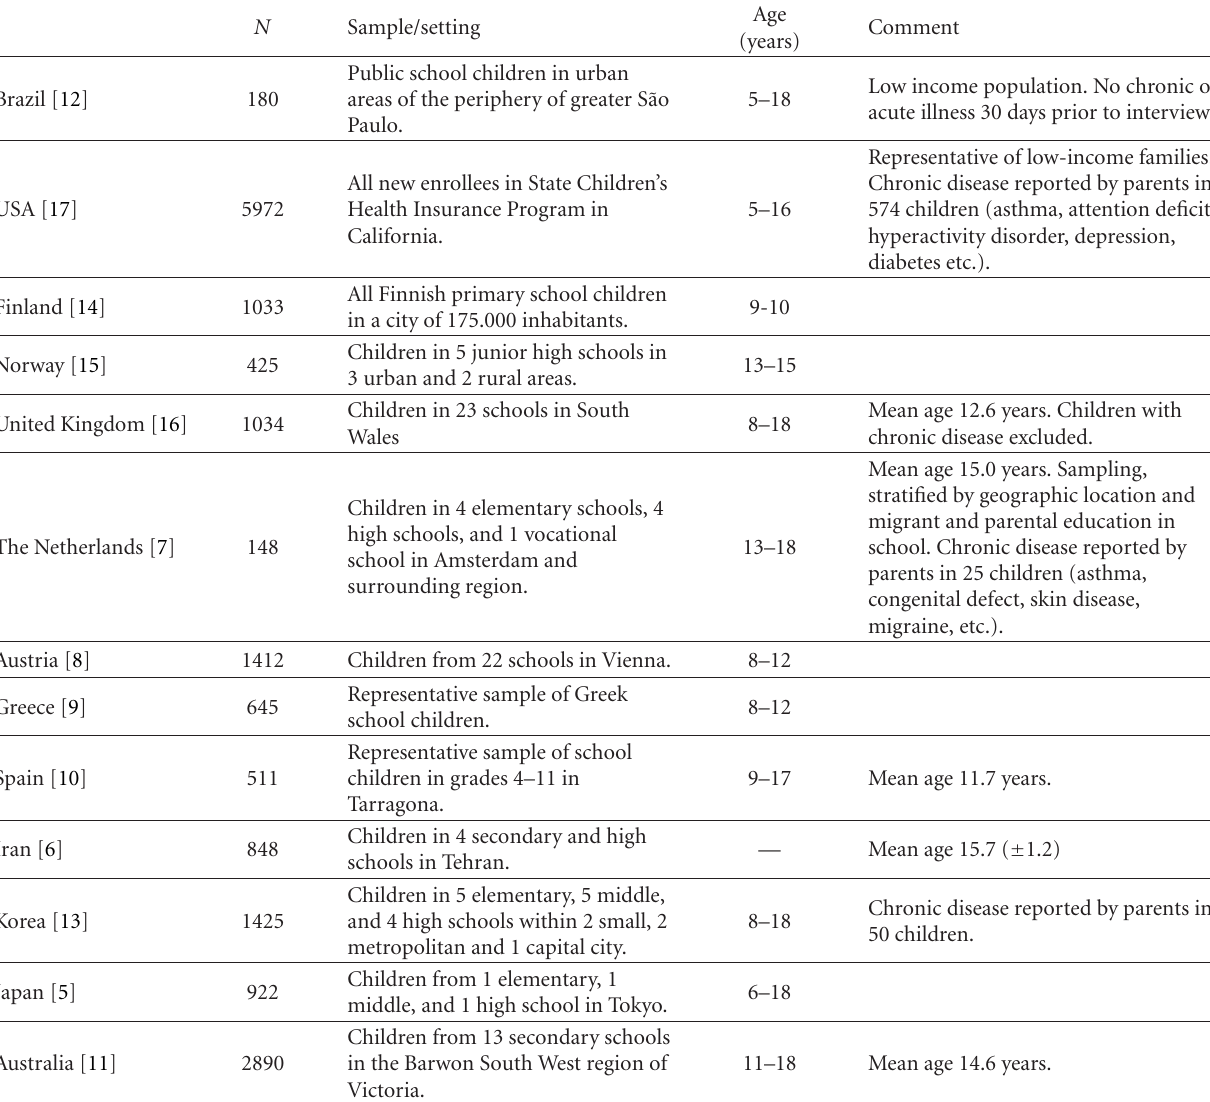
Table 5: Basic characteristics of community-based comparison